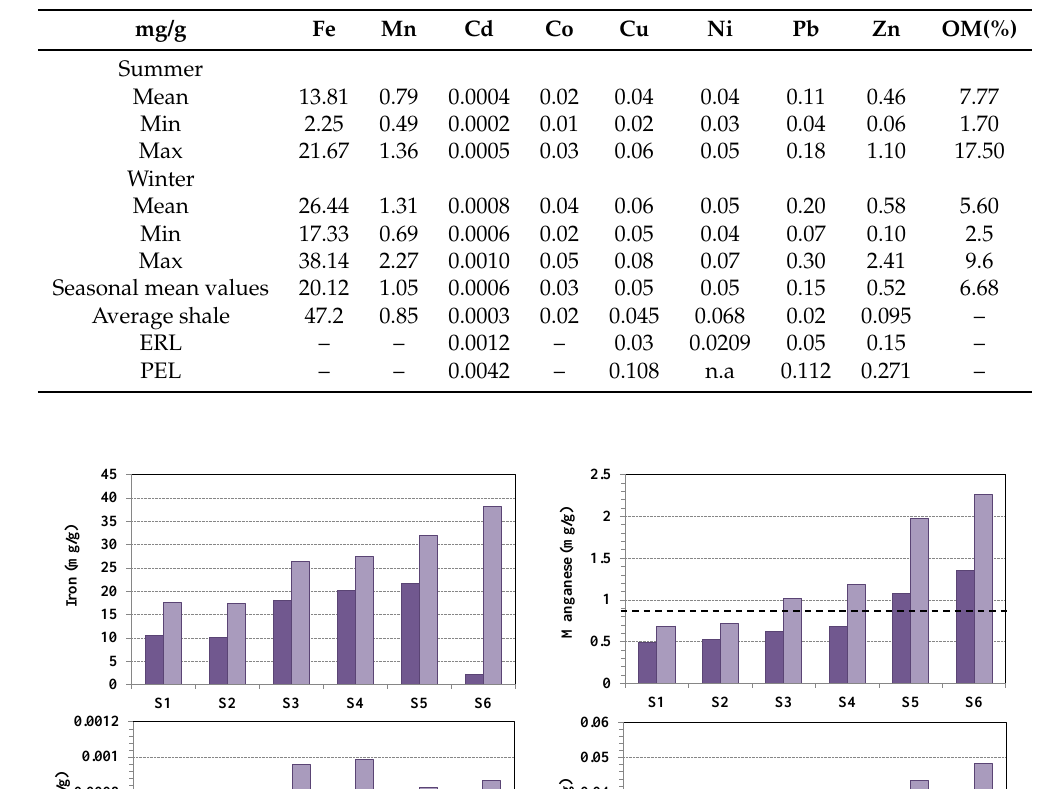
Table 2. Concentration of toxic trace metals and organic matter (%) in Damietta branch sediments during summer and winter seasons (mg/g).